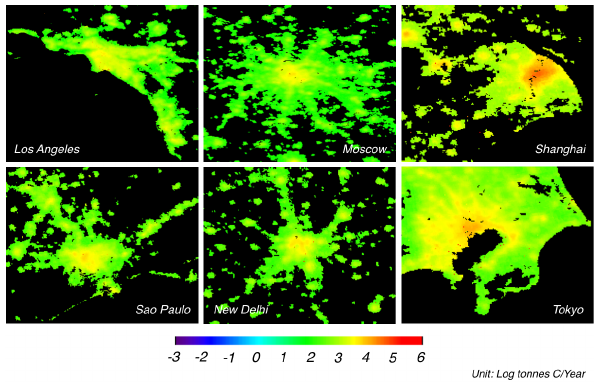
Fig. 7. Spatial distributions of CO 2 emissions over heavily populated cities worldwide for the year 2006. From top left (clockwise): Los Angeles, Moscow, Shanghai, Tokyo, New Delhi, and Sao Paulo. The maps were drawn using the original 1-km-resolution ODIAC inventory; therefore, the actual size of each pixel is 1 × 1 km 2 . Values are given in units of the log (base 10) of tonnes carbon 1 km − 2 year − 1 . Note that the maps are drawn in different scales.